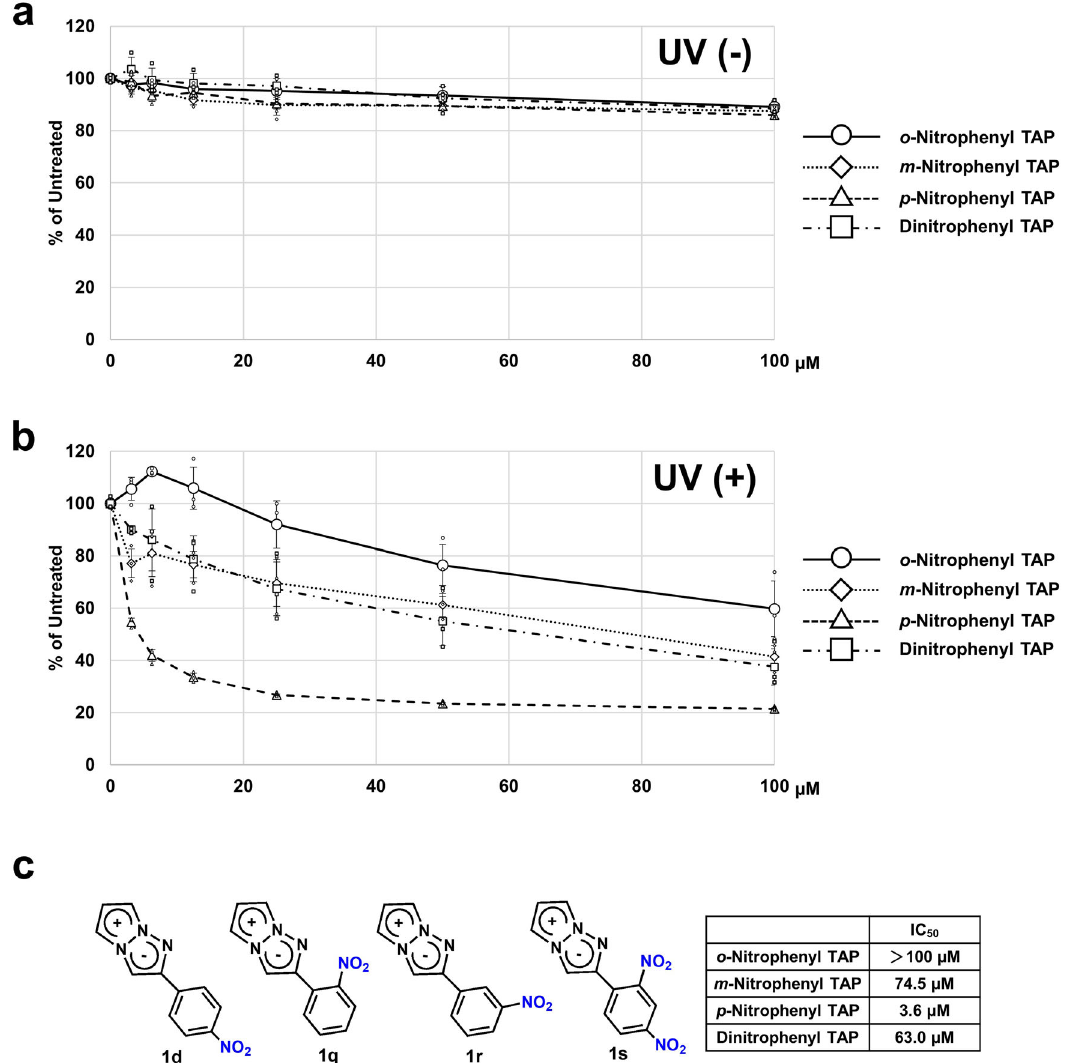
Fig. 3 Photo-induced cytotoxic effect of nitrophenyl analogs. a HeLa cells were cultured with several concentrations of TAP derivatives, and the cytotoxic effect without photoirradiation was determined by WST8 assay. b HeLa cells were cultured with several concentrations of TAP derivatives, and the photo- induced cytotoxic effect with UV irradiation was determined by WST8 assay. N = 3 biologically independent samples. The error bars represent the standard deviation of the mean. c Structures of nitrophenyl analogs 1d, 1q-s and their IC 50 values. 4-Nitrophenyl analog 1d showed much stronger photo- induced cytotoxicity than the other nitrophenyl analogs.